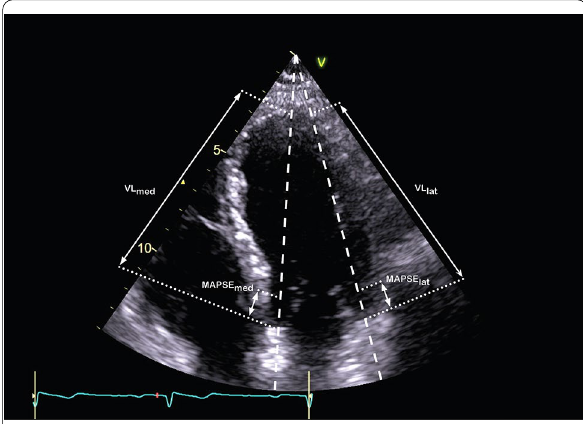
Fig. 1 Measurement of LV-LWFS from the A4C view. MAPSE was calculated from an average of lateral and medial measurements. Lateral and medial ventricular length were measured directly from the 2D image and averaged. MAPSE lat and MAPSE med medial mitral annular plane systolic excursion, respectively, VL lat and VL med lateral and medial left ventricular length, =